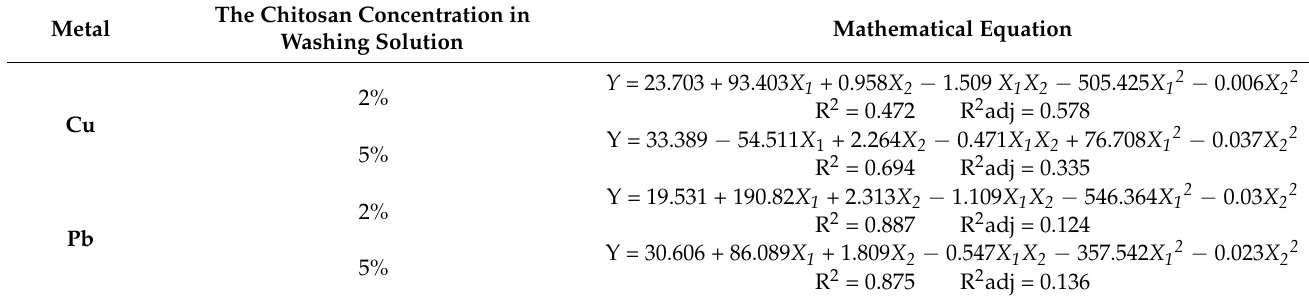
Table 3. Mathematical relationships that describe the evolution of the depollution process by washing the soil with chitosan solution.